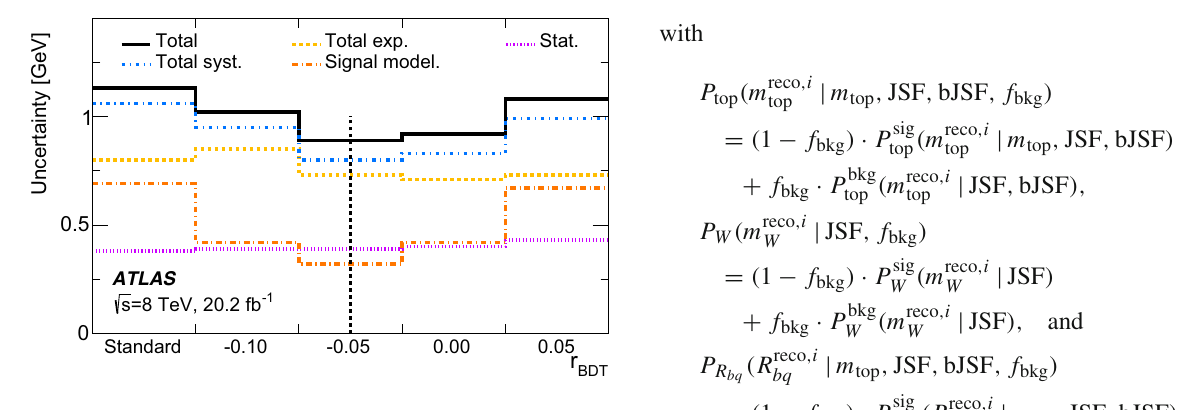
Fig. 3 Various classes of m top uncertainties as a function of the mini- mum requirement on the BDT output r BDT and for the standard selec- tion.Thetotaluncertainty(solidline)isthesuminquadratureofthesta- tistical (dotted line) and total systematic uncertainty (short dash-dotted line). The total systematic uncertainty consists of the total experimental (dashed line) and total signal-modelling uncertainty (long dash-dotted line). The uncertainties in the background estimate are included in the total experimental uncertainty. The minimum requirement on r BDT defining the BDT selection is indicated by the vertical black dashed line. All uncertainties are included except for the method and the pile- up